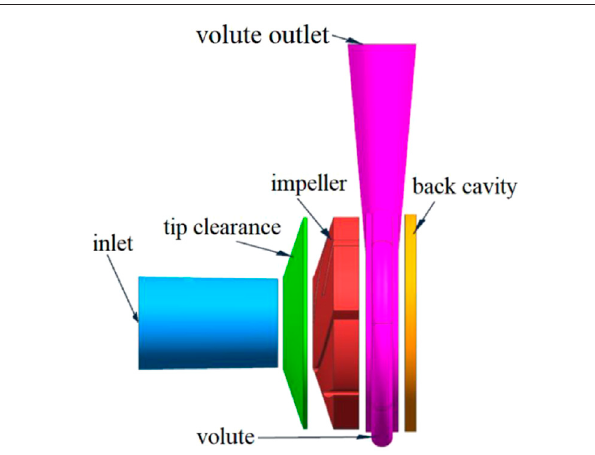
FIGURE 3 | Computational domain of Centrifugal Pump.